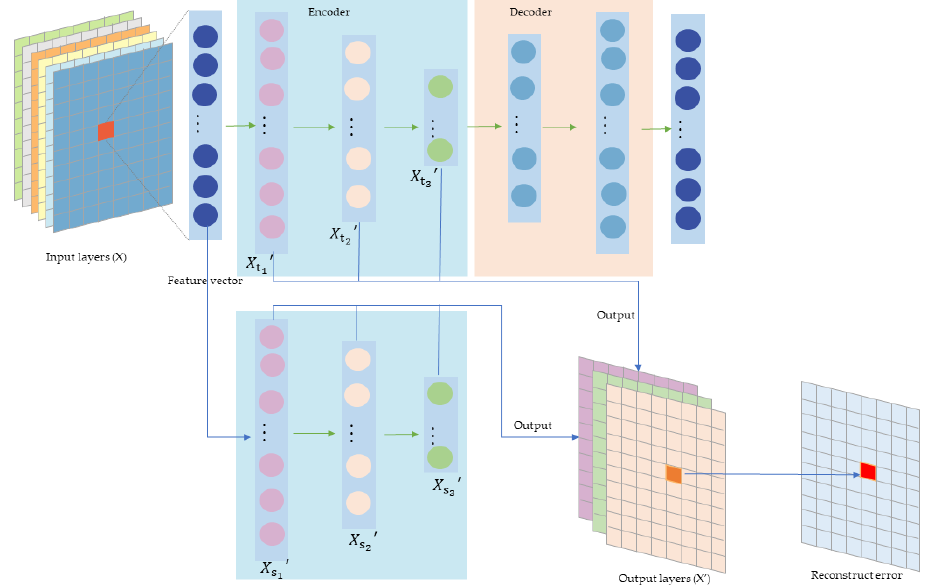
Figure 5. STOAD network structure.